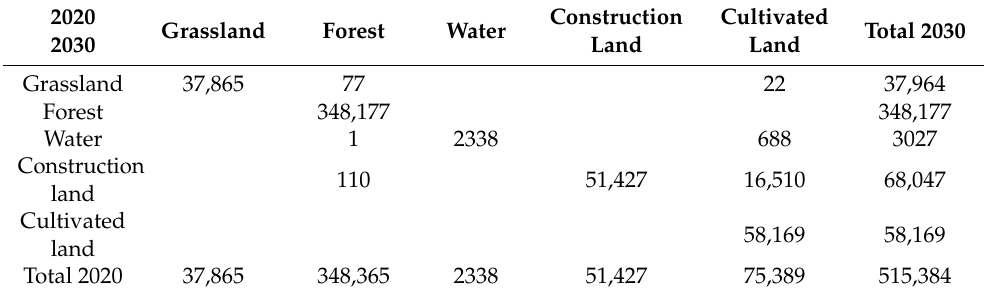
Table 12. Land-use area transfer matrix under the regional planning policy impact of the ECA in western Beijing from 2020 to 2030 (unit: hm 2 ).